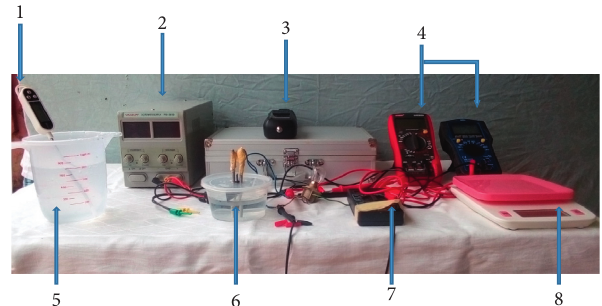
Table 2: Specifications of the DC power supply.